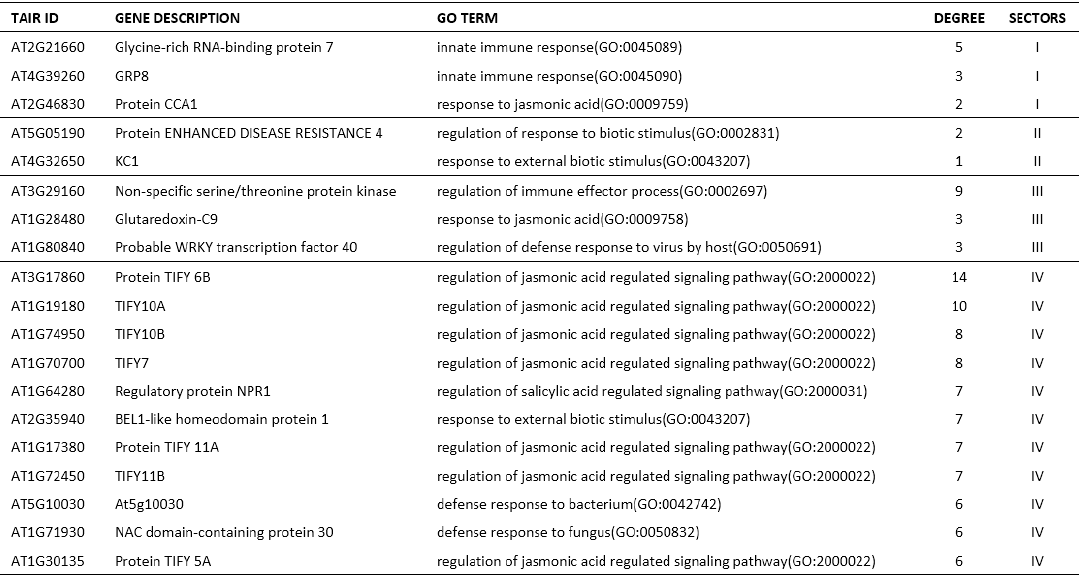
Figure 2. Arabidopsis transcriptome guided SAM immune interactome network analysis. ( A ) The Arabidopsis thaliana generic interactome (AT-Interactome) according to the Plant Interactome Database (http://interactome.dfci.harvard.edu/A_thaliana/index.php?page=download) is visualized in Cytoscape3.7.1. Nodes are denoted as dots, while non-directional edges are shown as gray lines between nodes. Green nodes in the network are proteins in which genes are differentially expressed in the SAM. The network with average connectivity among the nodes is clustered together (upper panel), while sparsely connected (liner nodes) in the networks are shown below the densely connected networks. ( B ) The differentially expressed genes (DEGs) from all 10 SAM populations are mapped onto the AT-interactome (nodes in green color) to contextualize the SAM protein-protein interaction network. Based on immune-enrichment analysis (GO terms pertaining immune/defense function), the nodes of the SAM-interactome with immune functions are highlighted in yellow. The SAM-interactome is further deconvoluted into four prominent sectors (Sector I: LAS-, HGD4-, and CLV3p-expressing cells, Sector II: AtML1- and HMG-expressing cells, Sector III: KAN-, FILp-, WUS-expressing SAM cells, and Sector IV: S17- and AtHB8-expressing cells). ( C ) Nodes of the SAM interactome with immune functions and their connectivity and functional